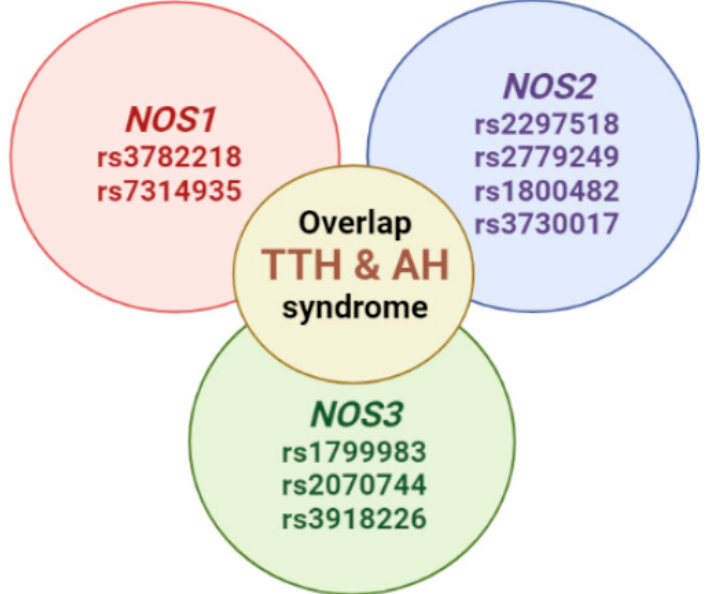
Figure 2. Potential SNVs of NOS1, NOS2, and NOS3 genes predisposed to the tension-type headache and arterial hypertension overlap syndrome (modification by authors from [2]).